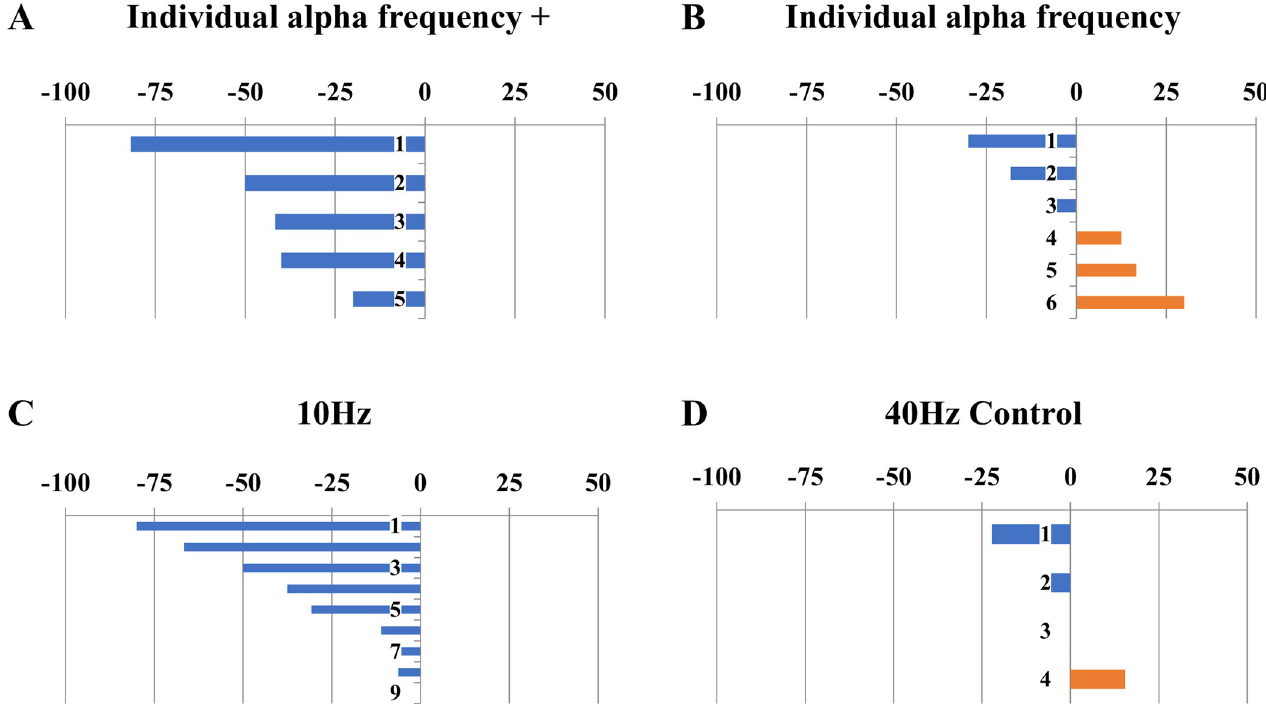
Fig 5. Percentage treatment response by stimulation type. Percentage change in symptoms after 10–12 sessions of alpha tACS according to type of stimulation used: (A) higher than IAF, (B) IAF, (C) standard 10Hz, (D) standard 40Hz. These figures combine both anti-phase and in-phase stimulation.